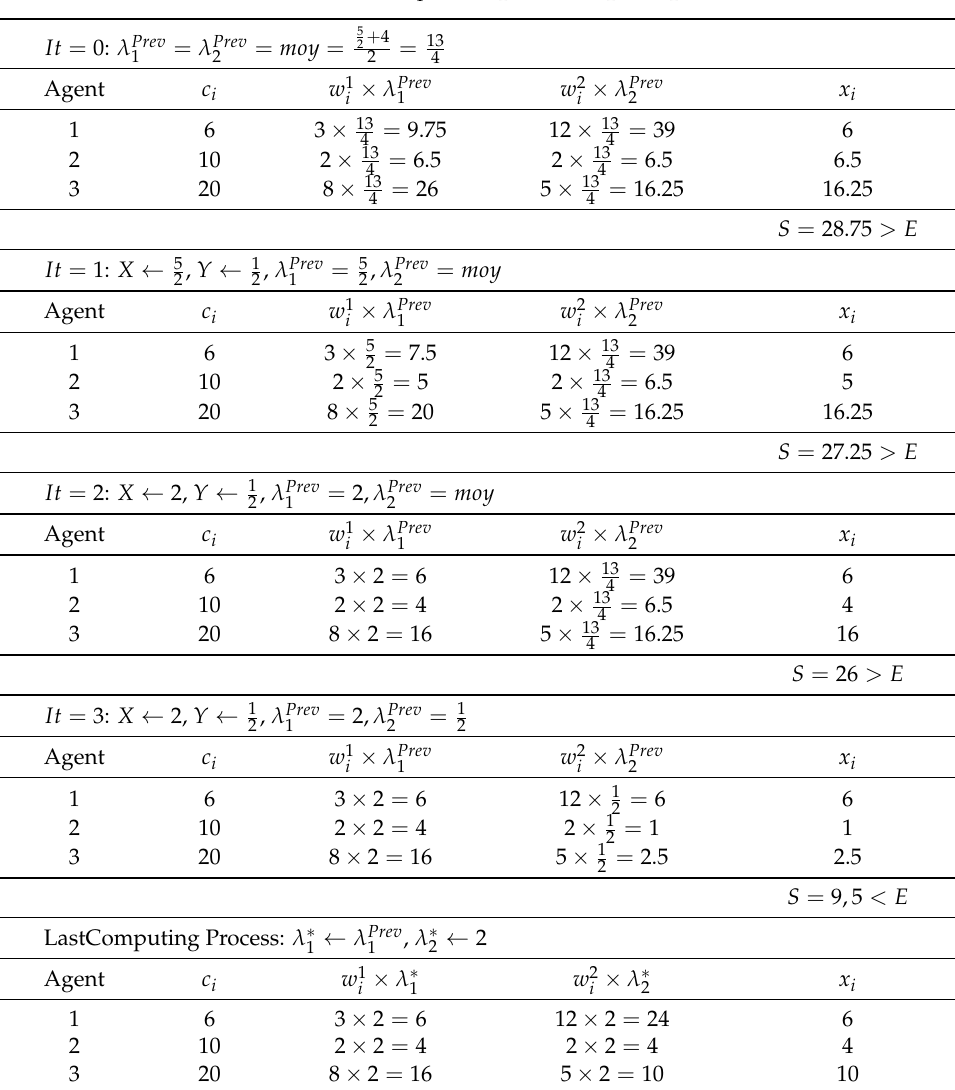
Table 2. Parameters computed at each the iteration It of Algorithm 1 on the double-weighted bankruptcy situation of Example 1, with λ S